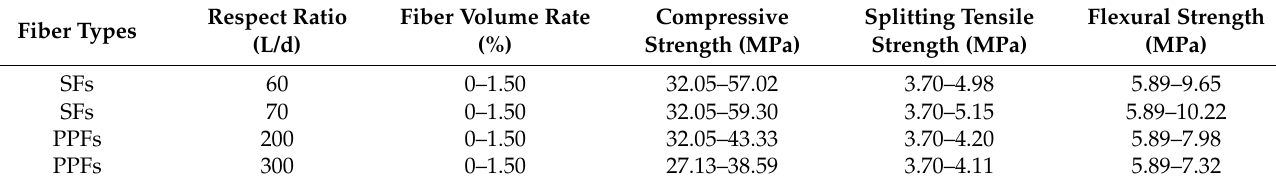
Table 9. The effect of aspect ratio on geopolymer concrete [97].